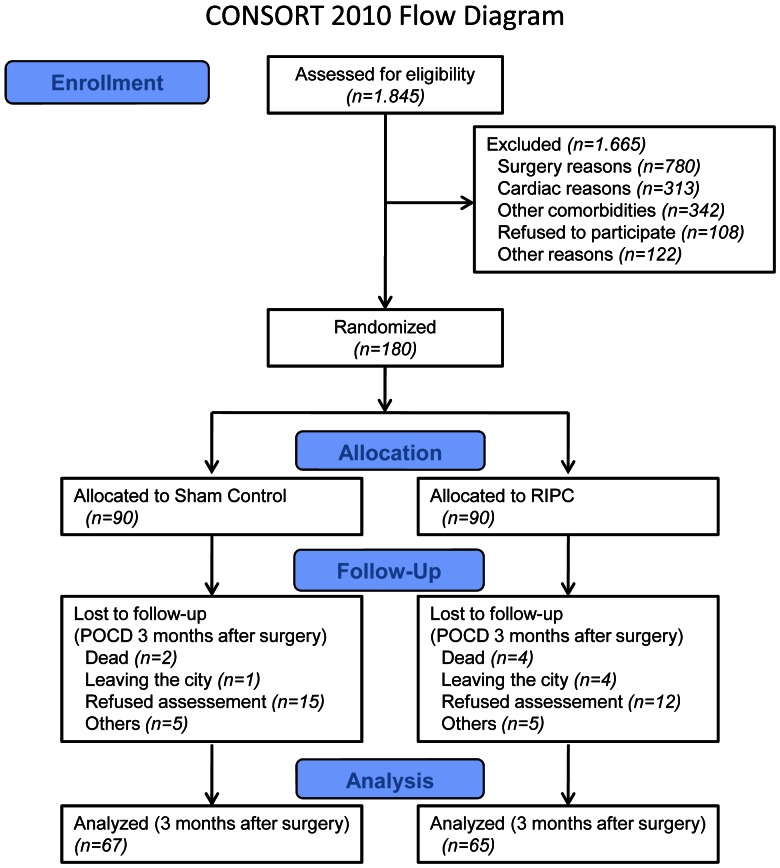
CONSORT flow diagram for individual randomized, controlled trials of nonpharmacologic treatment.Patients scheduled for cardiac surgery with use of cardiopulmonary bypass were included. The day before surgery we checked for eligibility, obtained informed consent, assessed baseline variables, laboratory tests and baseline neurocognitive function. At the day of surgery, standardized general anesthesia and management of cardiopulmonary bypass was performed in all patients. RIPC and control were performed immediately prior to cardiopulmonary bypass. Neurocognitive dysfunction was assessed 5–7 days and 3 months after surgery.